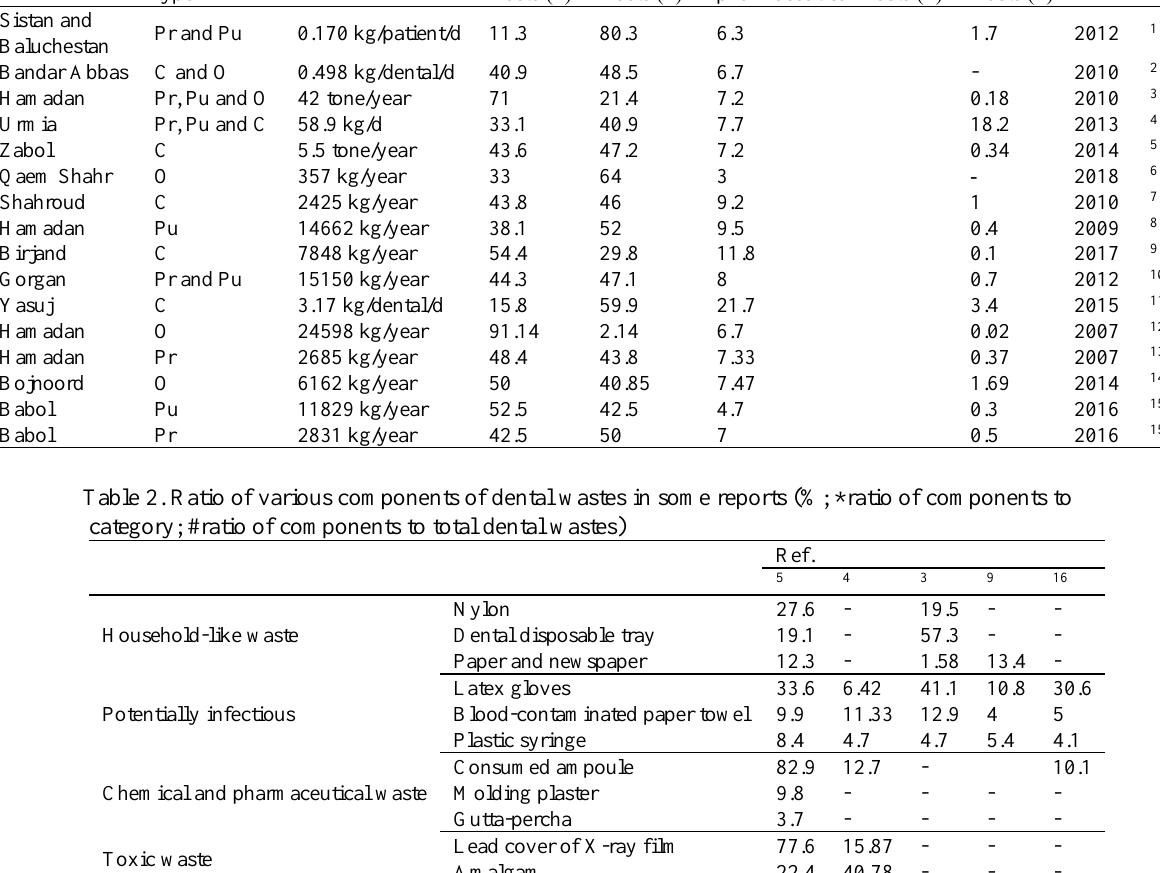
Toxic Year Ref. waste )٪(